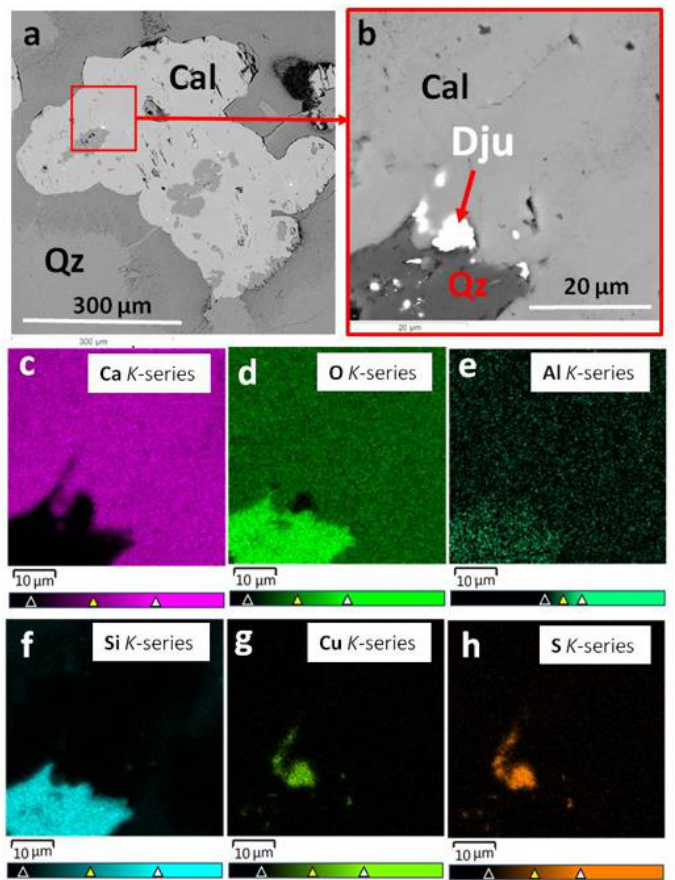
Figure 15. Calcite containing SiO 2 inclusions and djurleite (Dju) micro inclusions in a quartz matrix ( a , b ) from agate No 7 (Figure 4c,f). Element distribution in a fragment of calcite (Cal) (red square on a) ( b ) was determined using characteristic rays ( c – h ). ( a , b ) SE micrographs. Microinclusions of djurleite, phlogopite, and K-feldspar are located in quartz matrix (Figure 16a) at the edge of agate No. 4 (Figure 4b,e). Figure 16b – i shows the distribution of Si, O, K, Al, S, Cu, Mg, and Fe over the scanned area.